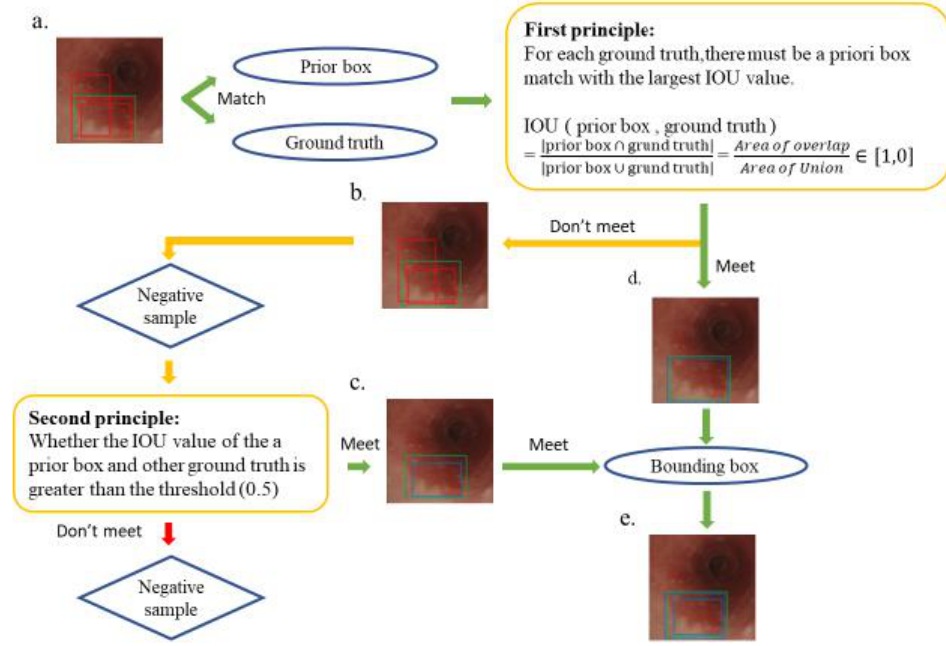
Figure 3. Schematic of the principle of matching ground truth with a prior box. The green box in the esophagus image is the ground truth, the multiple red boxes are prior boxes, and the blue box is the boundary box that finally matches the ground truth. ( a ) A match between multiple prior frames and ground truth; ( b ) a negative sample that does not meet the first principle during the matching process; ( d ) a positive sample that conforms to the first principle, which later becomes a boundary box; ( c ) a positive sample that does not meet the first principle but meets the second principle and also becomes a bounding box; and ( e ) the final output bounding box, which conforms to the first and second principles, which is the final SSD prediction.